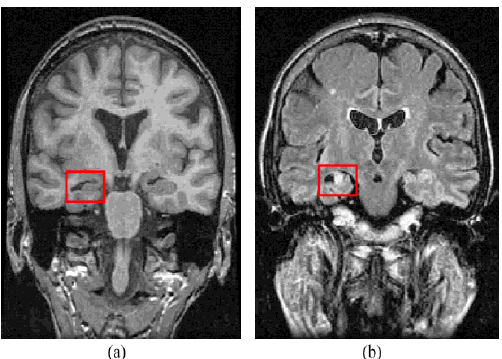
Figure 2. Mesial temporal sclerosis lesion ( a ) T1-weighted MRI and ( b ) FLAIR MRI